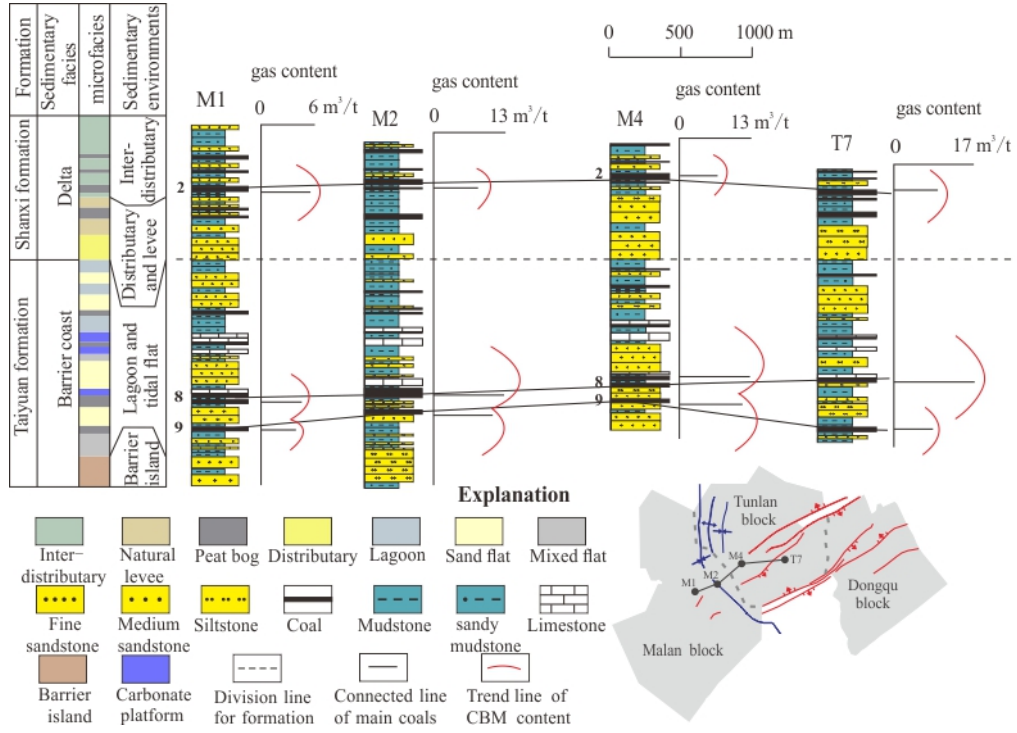
Figure 8. An E–W stratigraphic cross section showing vertical and lateral varieties in lithology of the Gujiao area associated with variable gas content of the major coal seams.